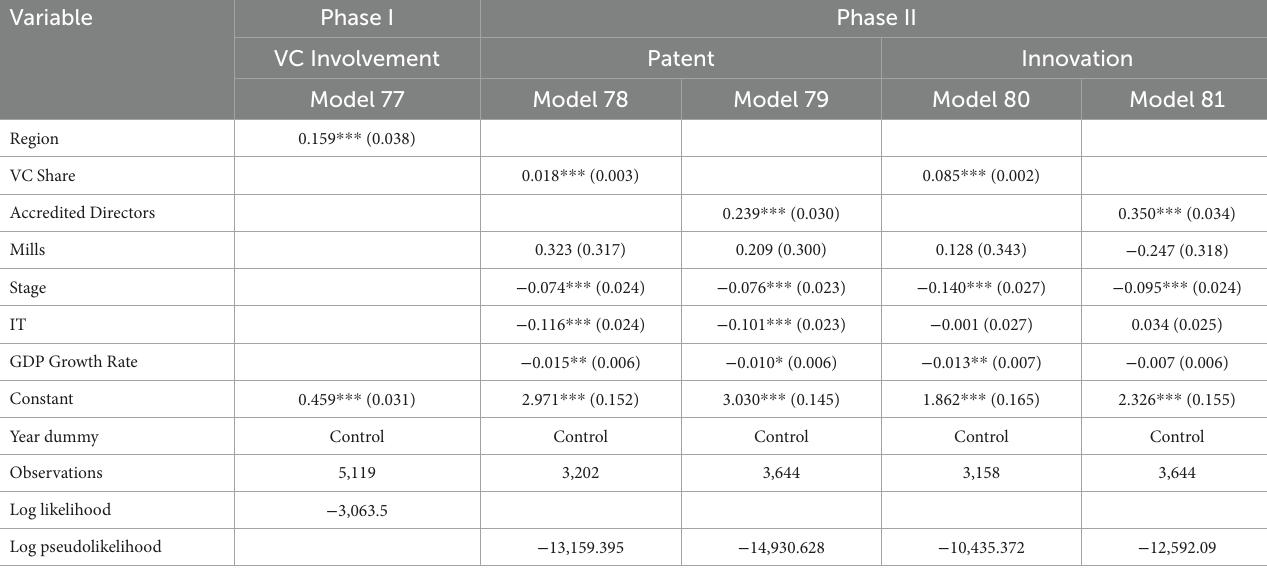
TABLE 14 Heckman treatment effect of VC’s shareholding and dispatched directors on enterprise innovation performance.